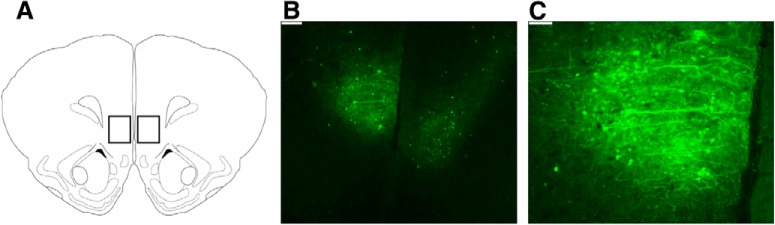
Visualization of GFP to verify injection site and extent of infected cells in the IL. A, Boxes of representative injection sites in the IL for NoT@P-ΔFosB males over coronal atlas diagram (Morin and Wood, 2001). B, Photomicrograph of GFP overexpression in a NoT@P-ΔFosB male; scale bar = 250 µm. C, Photomicrograph of GFP overexpression in a NoT@P-ΔFosB male; scale bar = 100 µm.